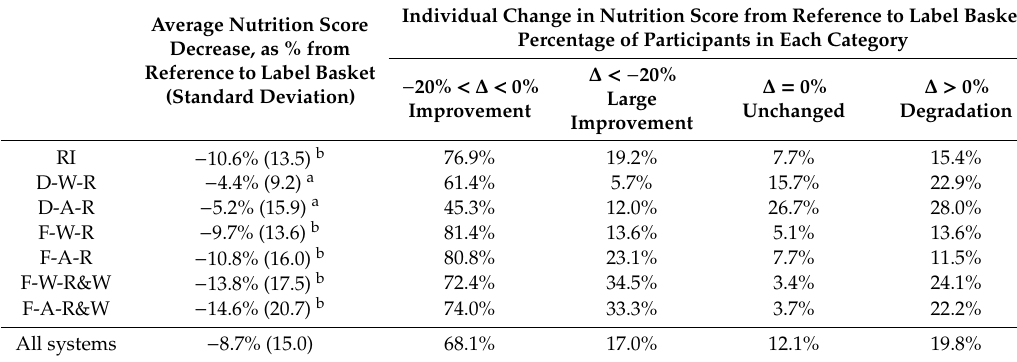
Table 7. FoPLs’ global and individual impact per